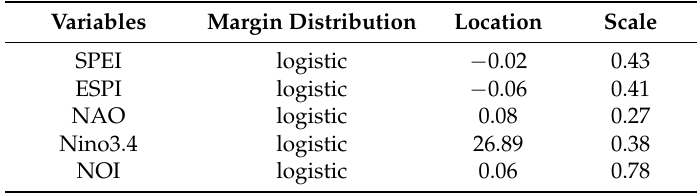
Figure 8. The joint probability distribution of SPEI and the GCV (when SPEI < 0.5). The intersection point indicates the probability of being less than the coordinate value at the same time. Table 3. The information on the marginal distribution of variables used in this study. Location and Table 4. The probabilities of Copula statistics. scale are two parameters of the logistic